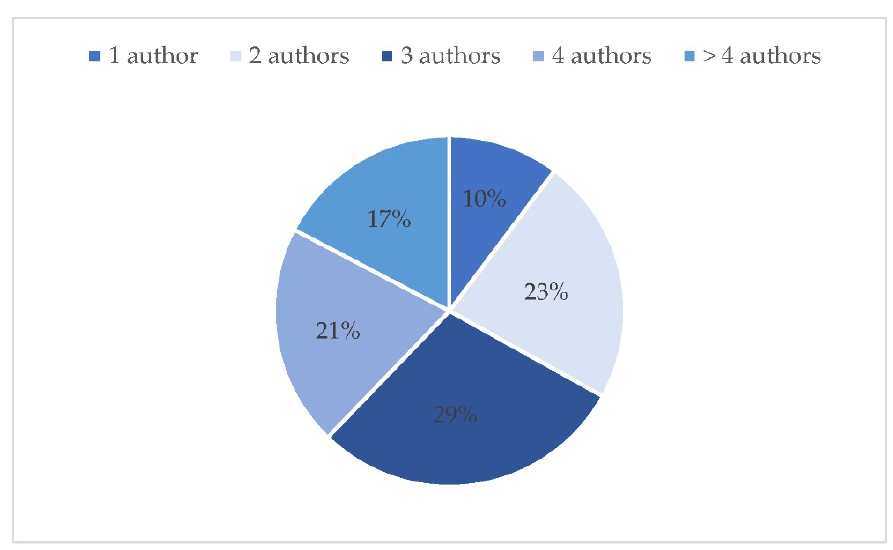
Figure 3. Percentage of papers by number of authors. Table 3. Overview of the most productive journals of our